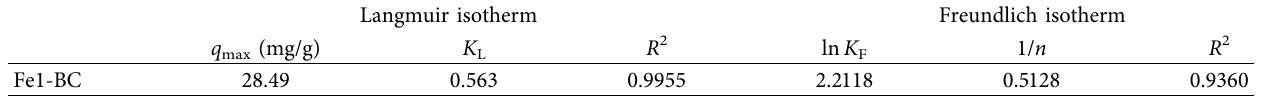
Table 1: Adsorption isotherm of Fe-modified BC.